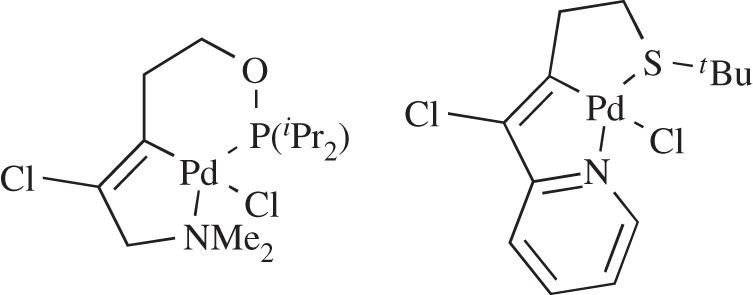
Unsymmetrical PCN [10] and SCN [11] palladacycles.